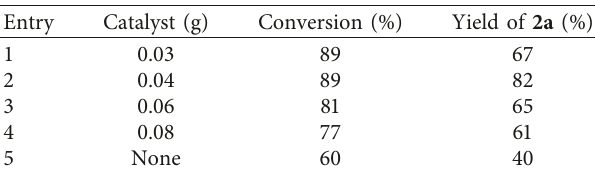
Table 4: Influence of the catalyst amount on the bromohydrox- ylation of 1a